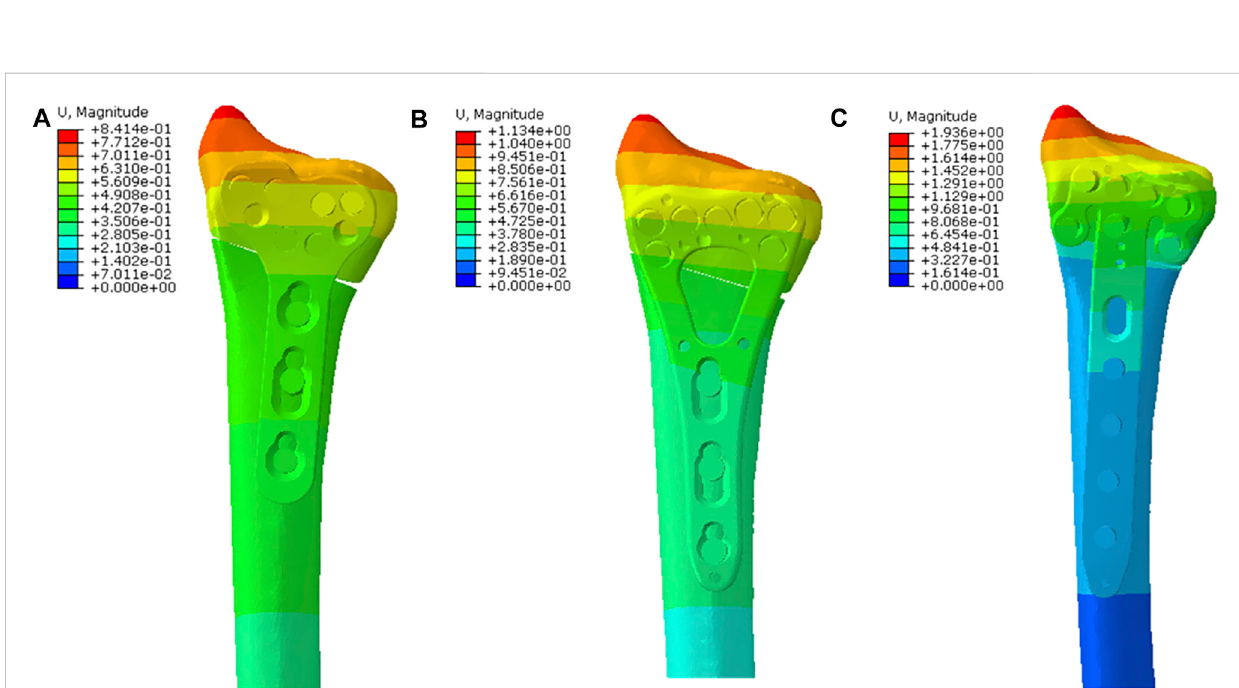
The displacement nephogram oftotalmodels and themostobviousdisplacement was observed atthedistalend. (A) Thenephogram intheTplate; (B) ThenephogramintheVplateandthetotaldisplacementwassimilartothatintheTplate; (C) Thenephograminthe π plateandthetotaldisplacement was higher than those in the other two